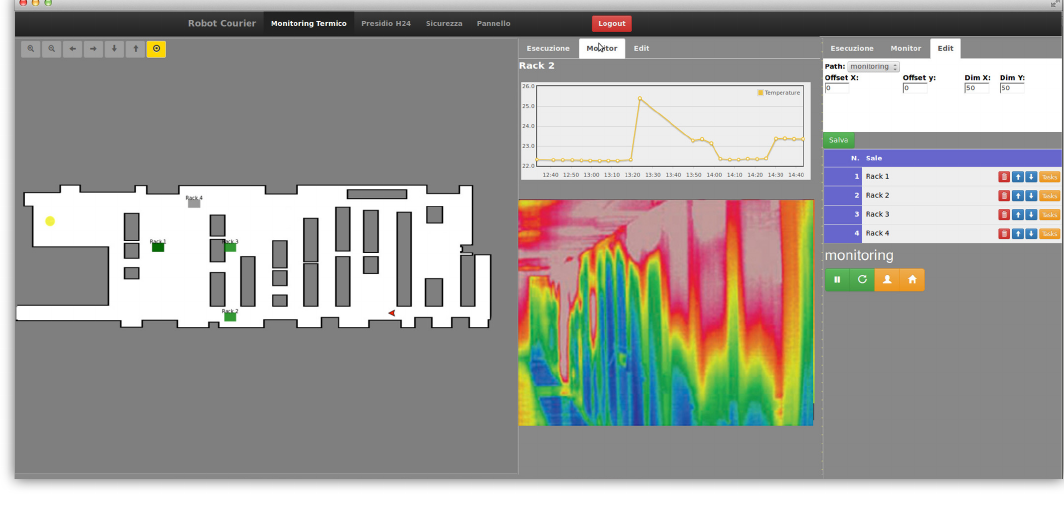
Figure 5. The web